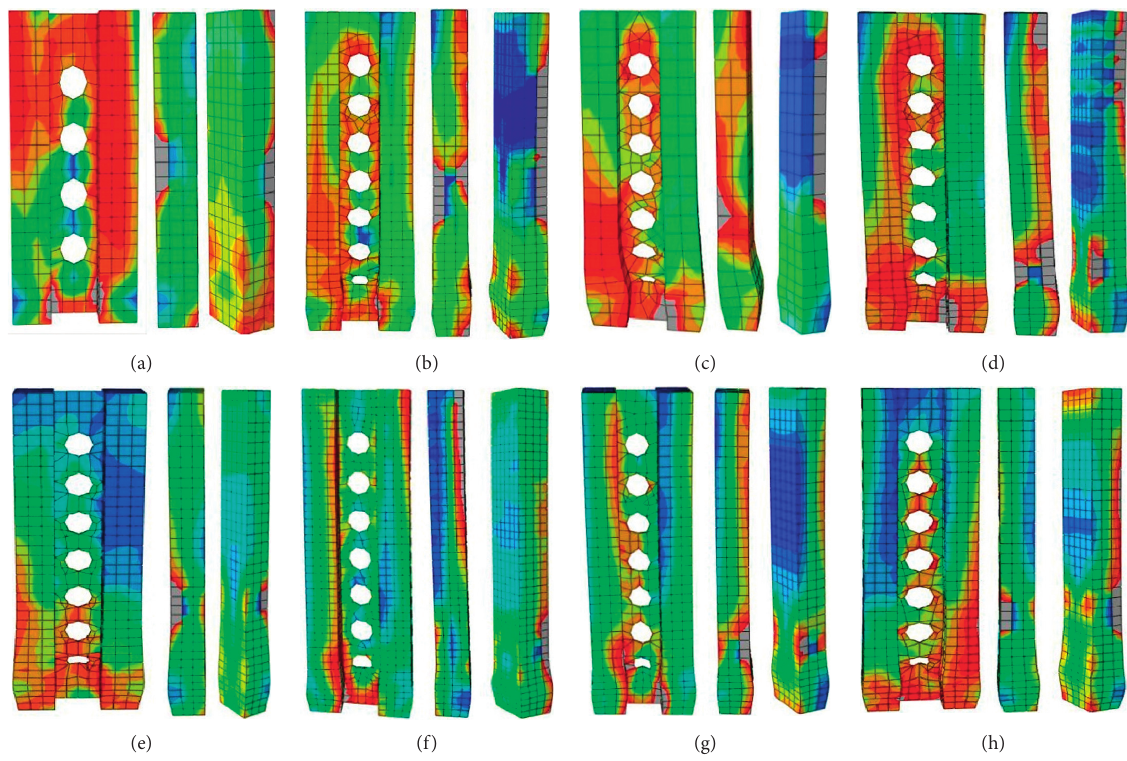
Figure 26: Failure modes of STHCCs. (a) STHCC2. (b) STHCC4. (c) STHCC6. (d) STHCC10. (e) STHCC13. (f) STHCC14. (g) STHCC19. (h)